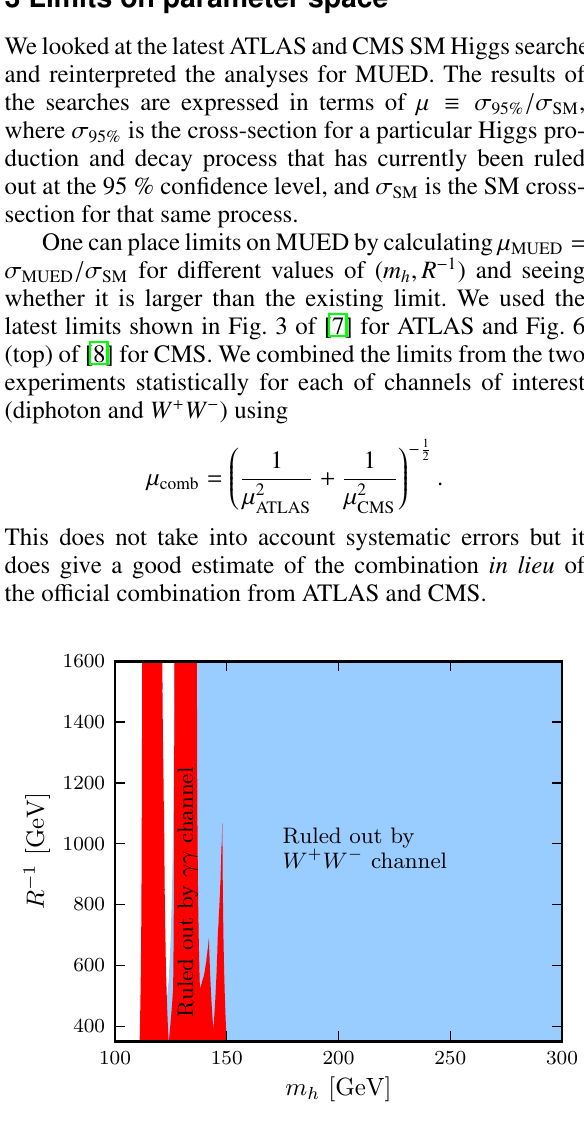
Fig. 3. Regions of MUED parameter space ruled out at the 95 % confidence level by combination of ATLAS and CMS Higgs searches using the diphoton (red) and W + W − (blue) channels.